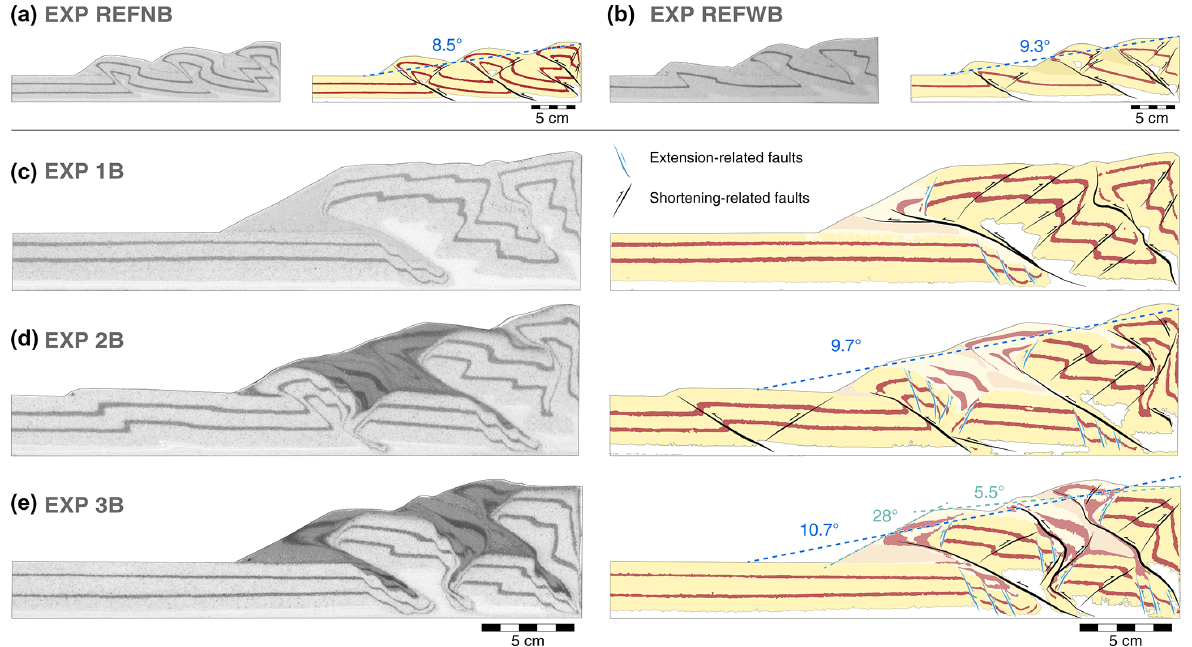
Figure 8. Side-view photographs and interpretation sketches for all models after 20cm of displacement, including visual guide for taper angle measurements. Values for EXP1B could not be determined as the taper is in transition into a critical taper, where no clear valleys or peaks are yet discernible in order to display a best-fitting line (Stockmal et al.,